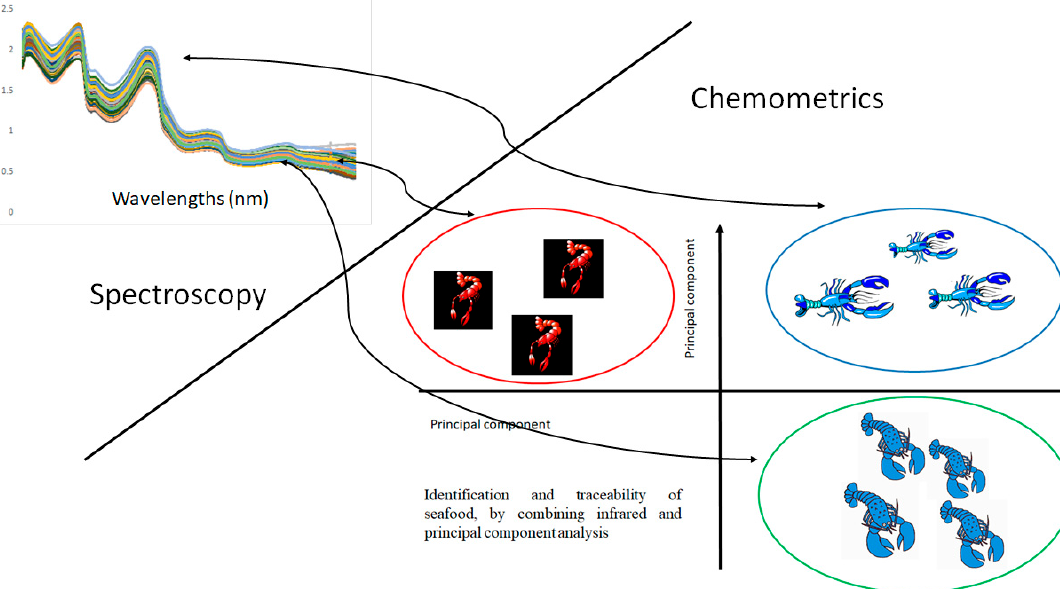
Figure 1. An illustration of the application of principal component analysis combined to vibrational spectroscopy to identify the origin of seafood.